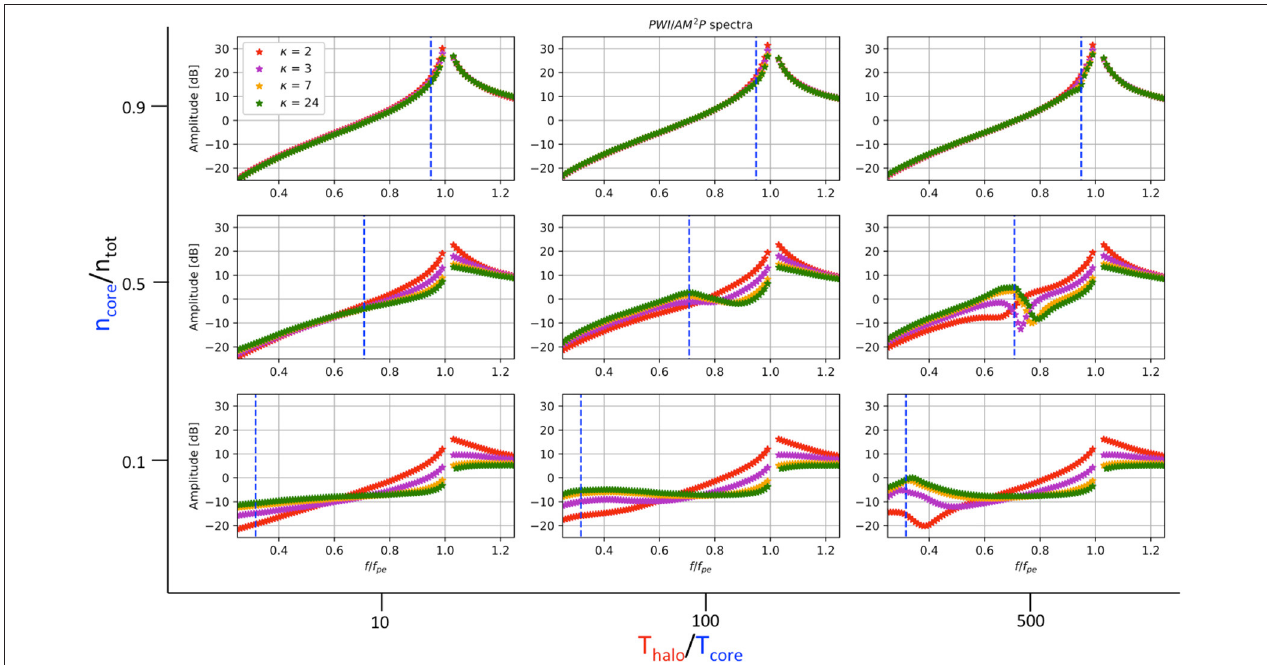
FIGURE 7 | Modeled PWI/AM 2 P mutual impedance spectra for λ D , ref = 4 m in a plasma modeled by a mix of a core Maxwellian evdf and a halo kappa evdf ( κ 2,3,7,24). The amplitude is expressed in 20 log 10 and the frequency is normalized by the electron plasma frequency. The core plasma frequency is shown by the = blue vertical dotted lines.